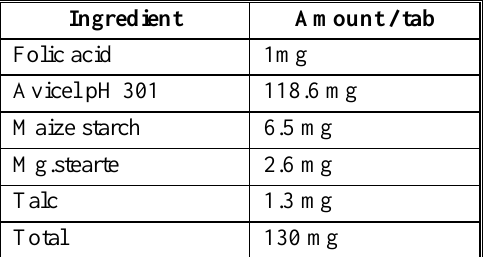
Table 1 : The formula of the prepared folic